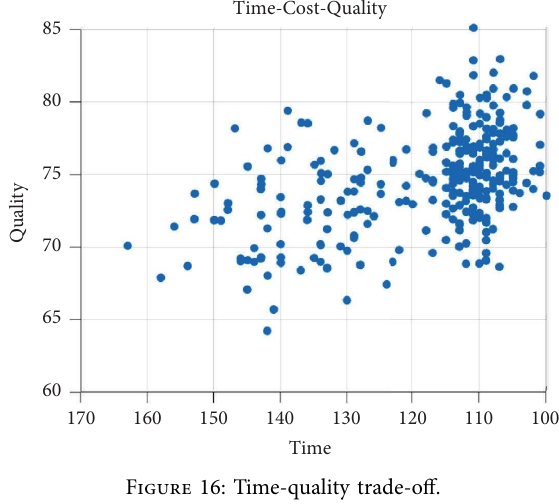
Figure 16: Time-quality trade-of.